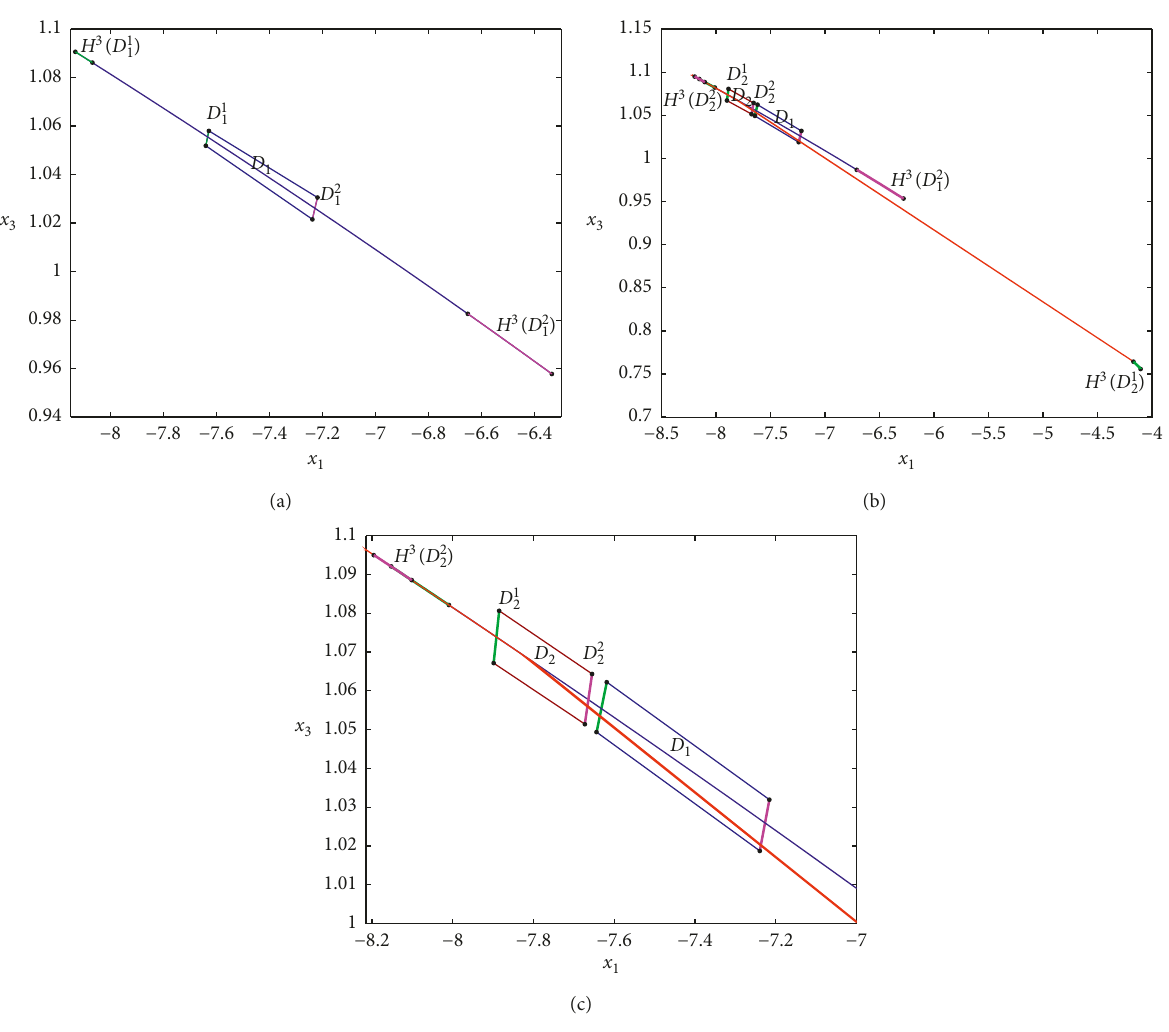
Figure 7: (a) The subset D 1 and its image; (b) and (c) the subset D 2 and its